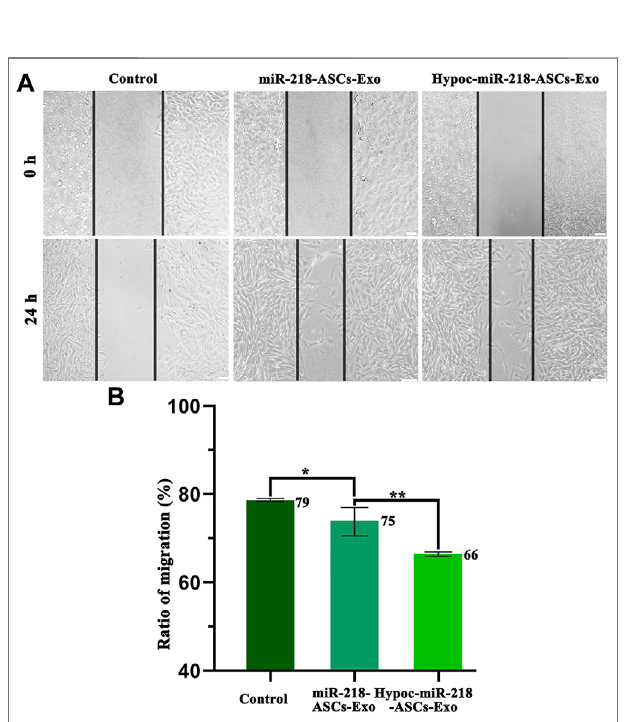
FIGURE 7 | Scratch assay and ratio of migration. (A) Images of control (untreated PC12 cells ’ group), miR-218-ASCs-Exo (miR-218-ASCs-Exo- treated PC12 cells ’ group), and Hypoc-miR-218-ASCs-Exo (Hypoc-miR- 218-ASCs-Exo-treated PC12 cells ’ group) at 0 and 24 h. (B) Ratio of migration (%) was calculated in three groups, respectively, at 24 h.